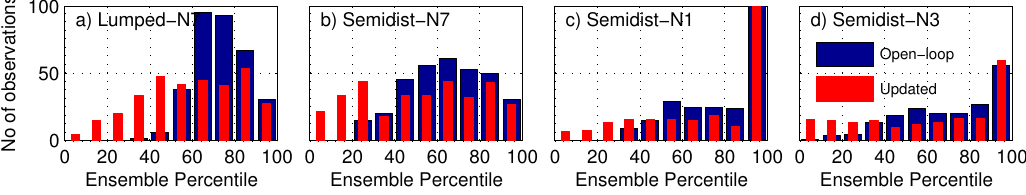
Figure 7. Rank histograms of the open-loop and updated streamflow ensemble predictions. (a) presents the results from the lumped scheme at node N7. (b) – (d) present the results from the semi-distributed (semidist) scheme at nodes N7, N1 and N3.